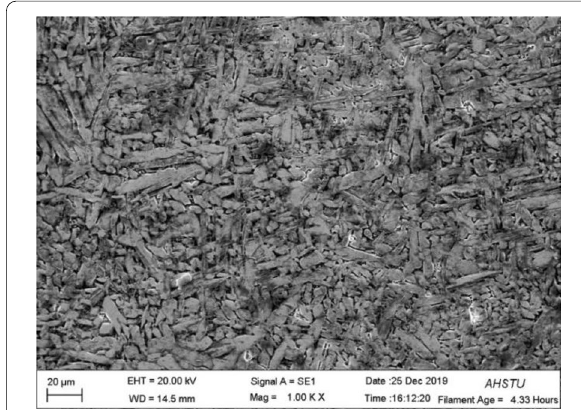
Figure 5 SEM image of the CuMn 13 Al 7 sample formed by wire arc additive manufacturing